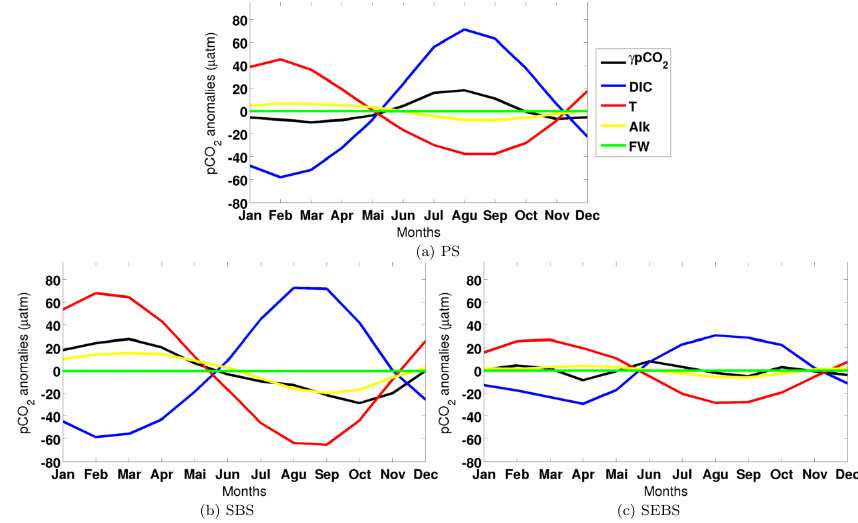
Figure 9. Temporal evolution of p CO 2 anomalies and their drivers in each continental shelf (right hand side of Eq. (1) using temporal anomalies), red line represents the effects of Temperature, blue line the effects of DIC s , green line FW, and yellow line ALK s